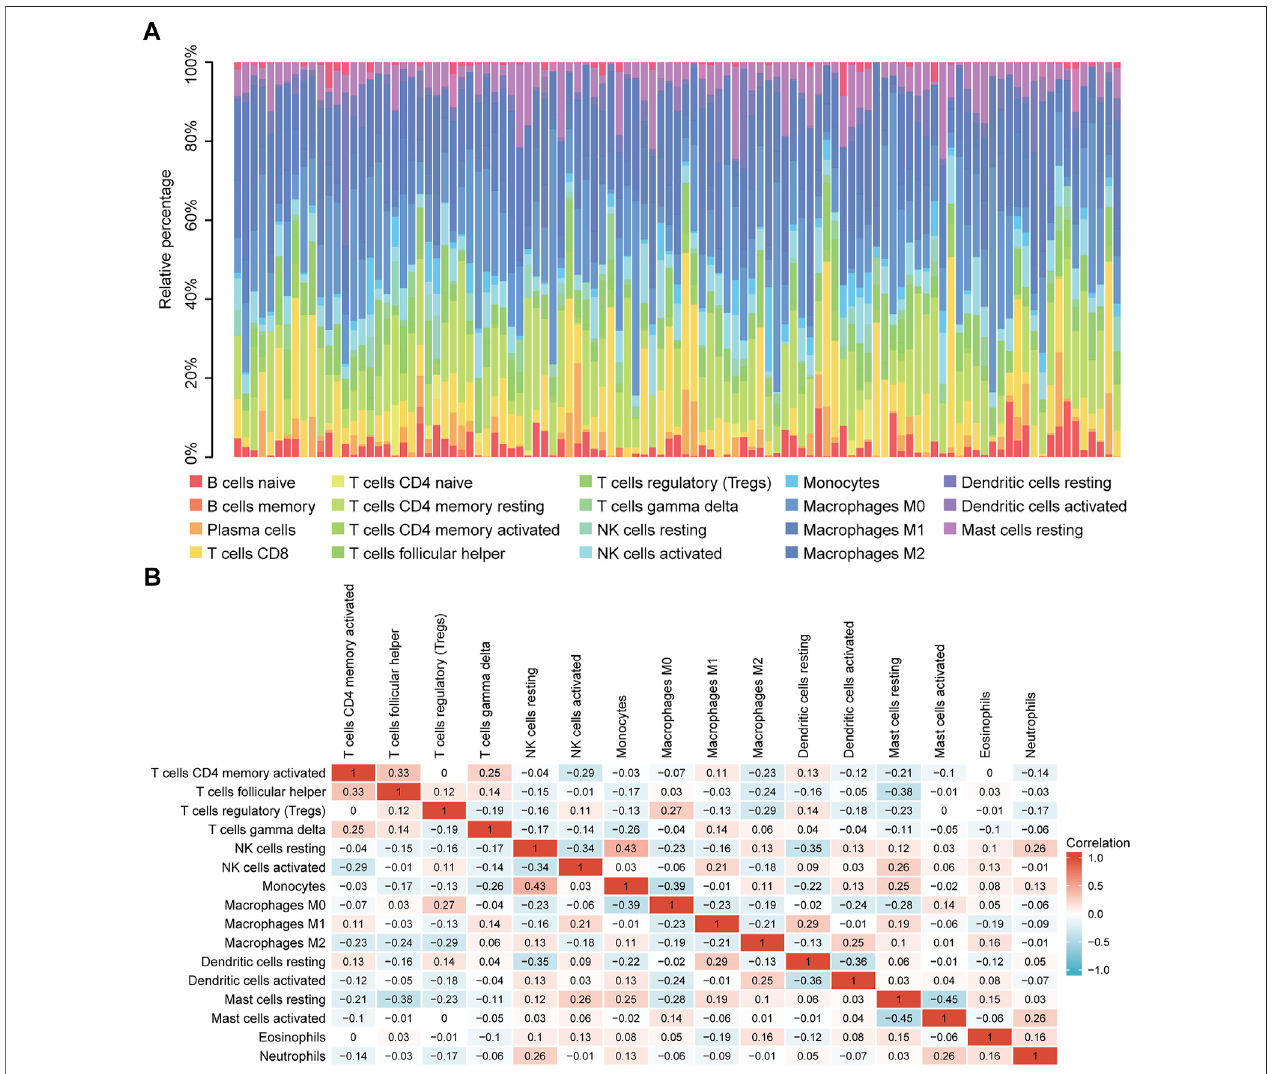
FIGURE8 | CIBERSORT analysis. (A) : Abundance ofimmune cells in TP53mutantTCGA-LIHC samples. (B) : Correlation heatmap between different immune cell in fi ltration.